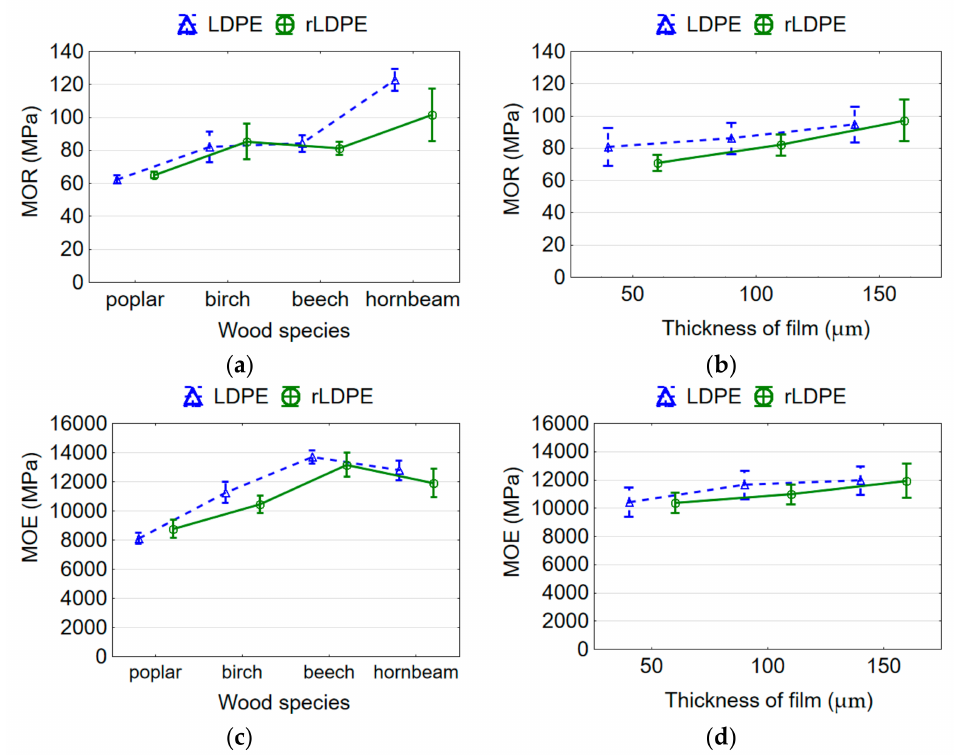
Figure 3. Mean plots of bending strength ( a , b ) and modulus of elasticity ( c , d ) of plywood samples depending on type of adhesive, wood species, and thickness of rLDPE/LDPE